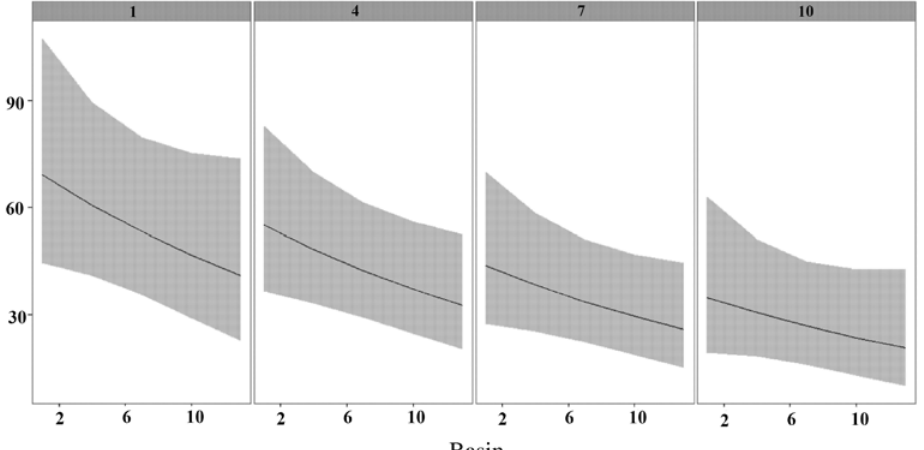
Fig 3. The predicted time spent in each fishway basin (seconds ± 95% confidence limits) as fish attempted pass through the fishway for the first (1), fourth (4), seventh (7), and tenth (10) time.